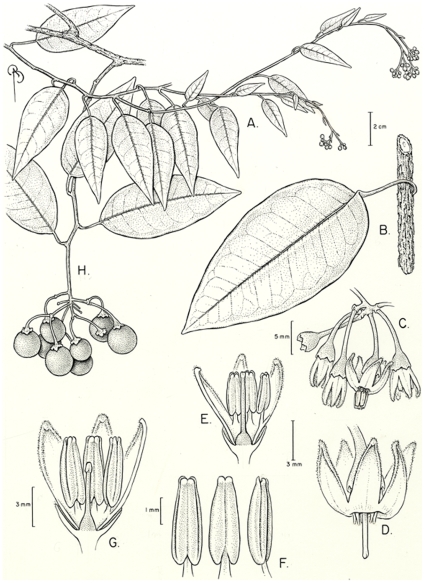

Solanum luculentum.A) portion of stem with flowering inflorescence, B) detail of stem with peeling bark, C) buds, D) open long-styled flower with anthers removed, E) long-styled flower cross-section, F) anthers, G) short-styled flower cross-section, H) fruiting inflorescence from putatively pistillate individual. A–B drawn from Nee & Callejas 32546, C–F from Steyermark et al. 127855, G from Steyermark & Dunsterville 100777, H from Killip & Smith 15952.